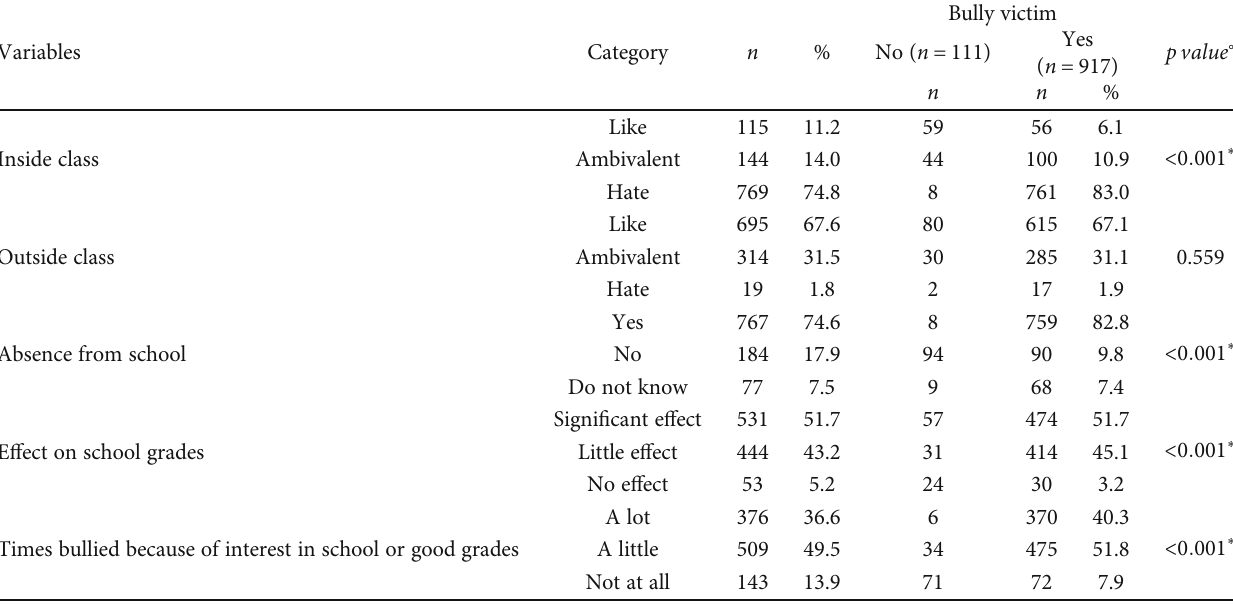
Table 2: Feelings toward school and relationship of academic performance and bullying.